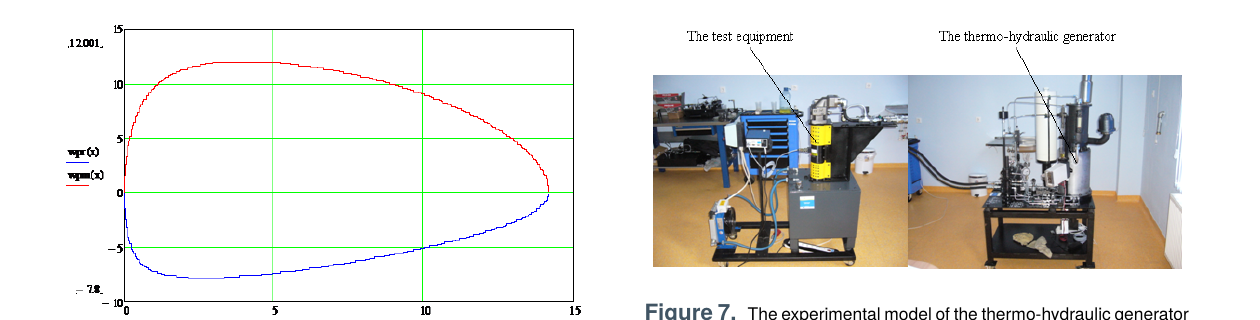
Figure 7. Theexperimentalmodelofthethermo-hydraulicgenerator single regime the optimization of the functioning is easier, without being in idle and with the possibility of breaking energy recovery). The thermal part of the propulsion sys- tem (the thermal-hydraulic generator) is characterized by the particularities of single regime running (no idle). It is estimated that, compared with the nowadays propulsion systems, the new thermal-hydraulic system has the fol- lowing advantages: lower fuel specific consumption and emissions (it is easier to optimize one regime instead of an infinity); simple construction; and greater reliability. On the basis of the computer model developed, an exper- imental model was built (see Figure